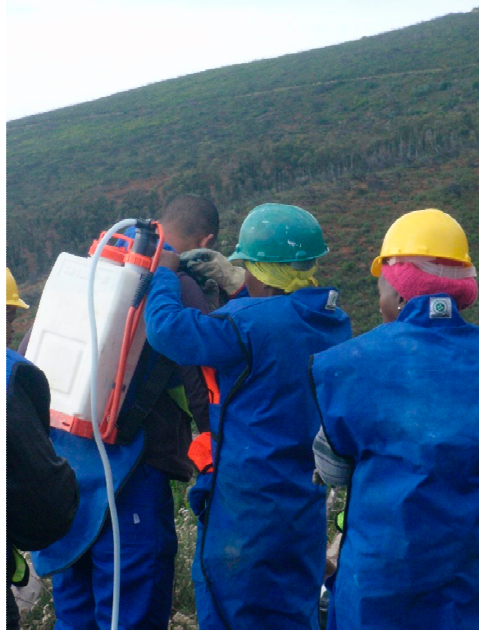
Figure 1. Example of Working for Water workers putting on backpack and Personal Protective Equipment (PPE) for herbicide spraying (Photo by Hanna-Andrea Rother).